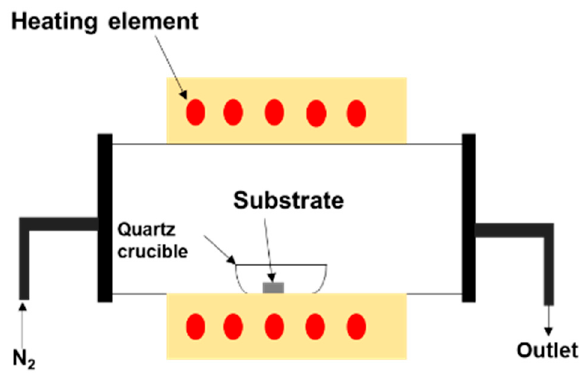
Figure 1. Illustration of the sample set-up inside the furnace, which was used to study the morphology of Ga 2 O 3 on different substrates. A mixture of liquid Ga as a source and Ag as a catalyst was placed on the surface of substrates to enhance the growth of Ga 2 O 3